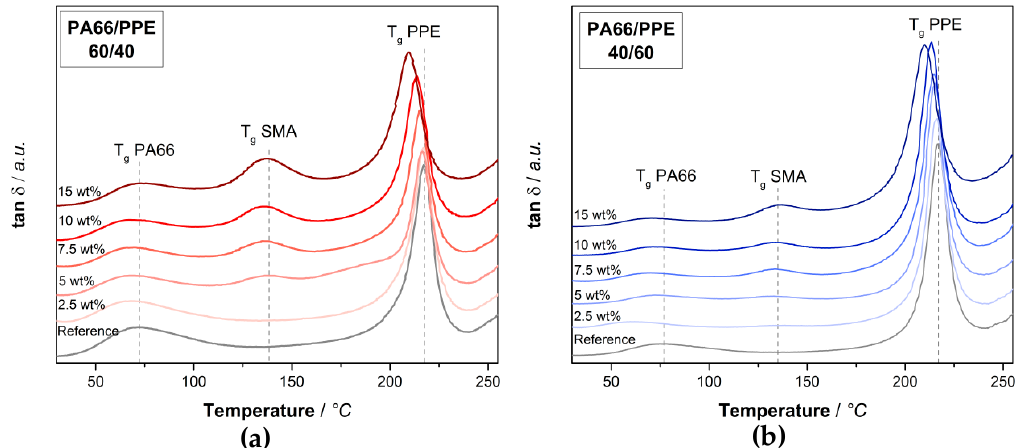
Figure 2. Tan δ plots polyamide 66 (PA66) / PPE / SMA ternary blends with ( a ) 60 / 40 blend ratio, ( b ) 40 / 60 blend ratio at various SMA contents.